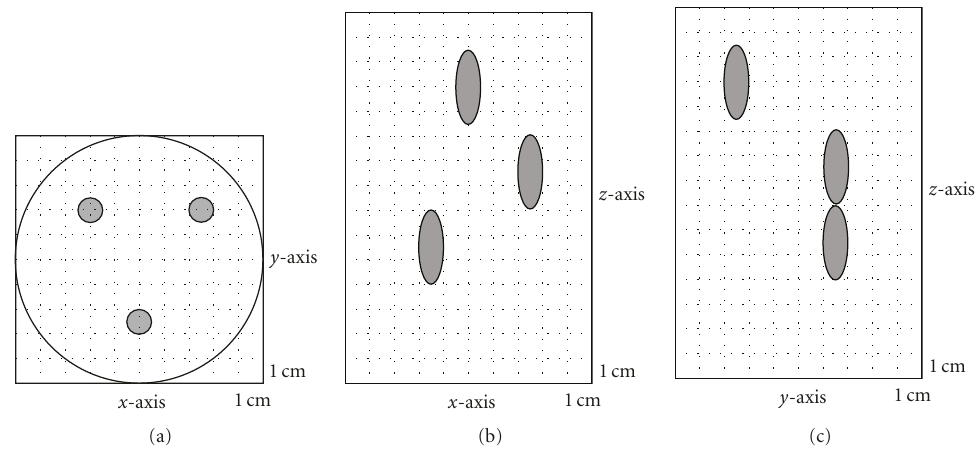
Figure 10: Physical setup for experiment 2. (a) ( x , y ) plane view, (b) ( x , z ) plane view, and (c) ( y , z ) plane view.